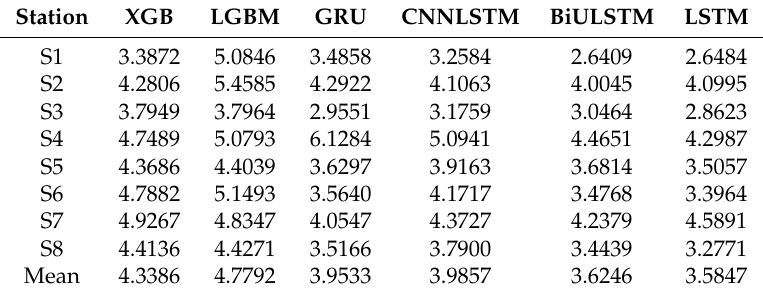
Figure 11. The predicted results of all models. Table 5. Models results for MAE (µg/m 3